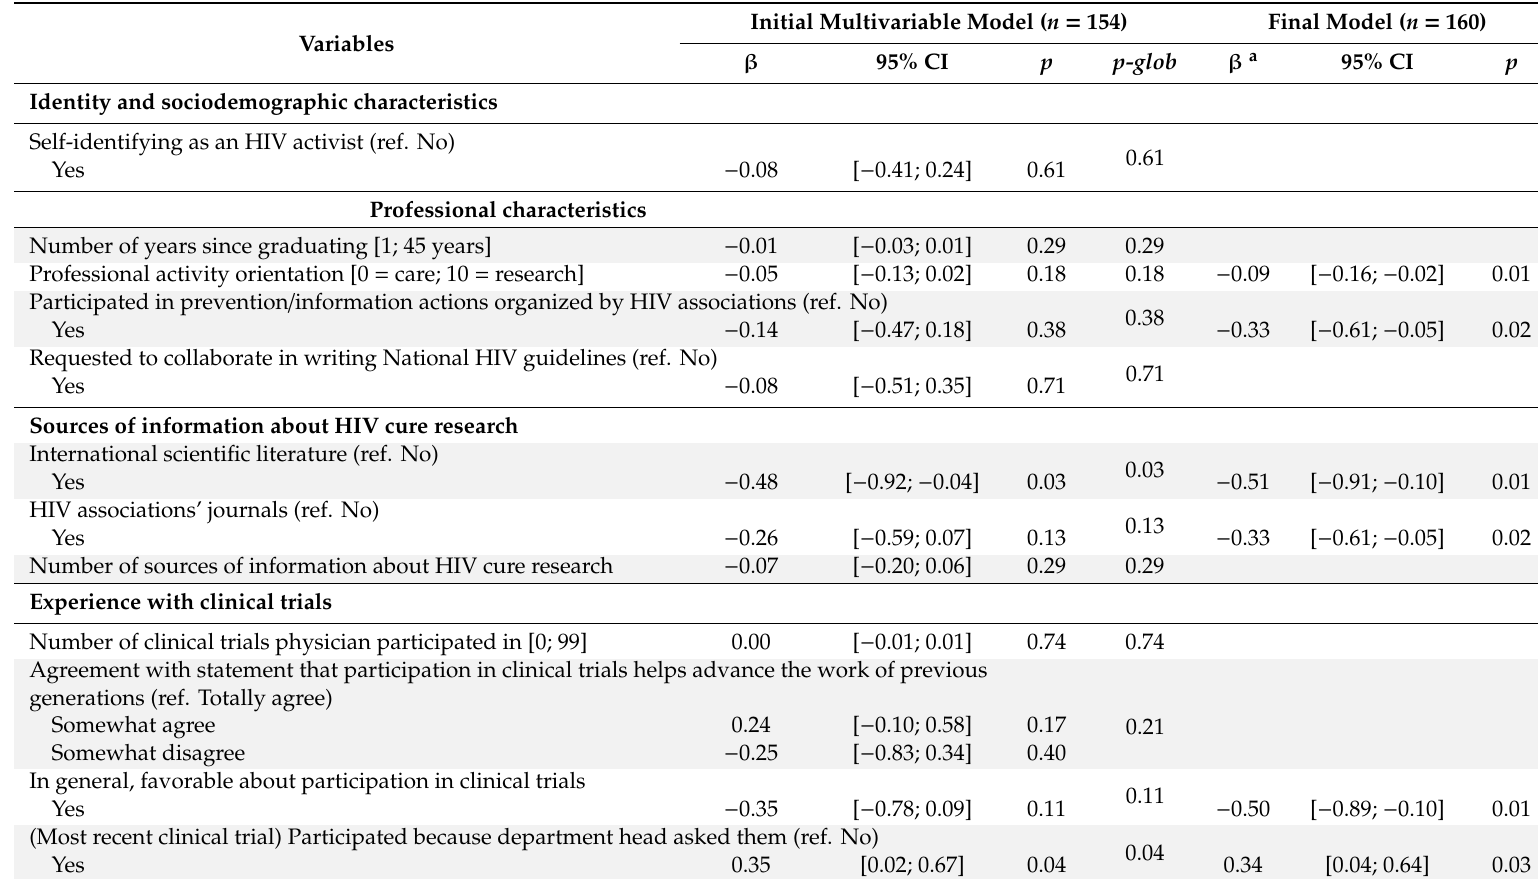
Table 2. Factors associated with the reluctance score: results from multivariable linear regressions—acceptability, expectations, and preferences for HCRCT among people living with HIV (PLWH) with undetectable viral load and caregivers, or ANRS-APSEC, study, n =